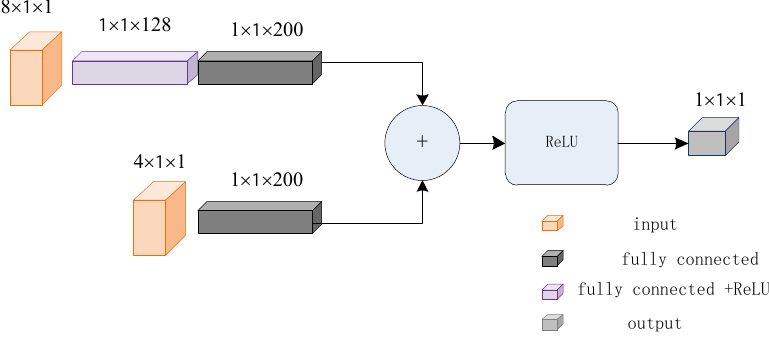
Figure 5. Q network structure design.